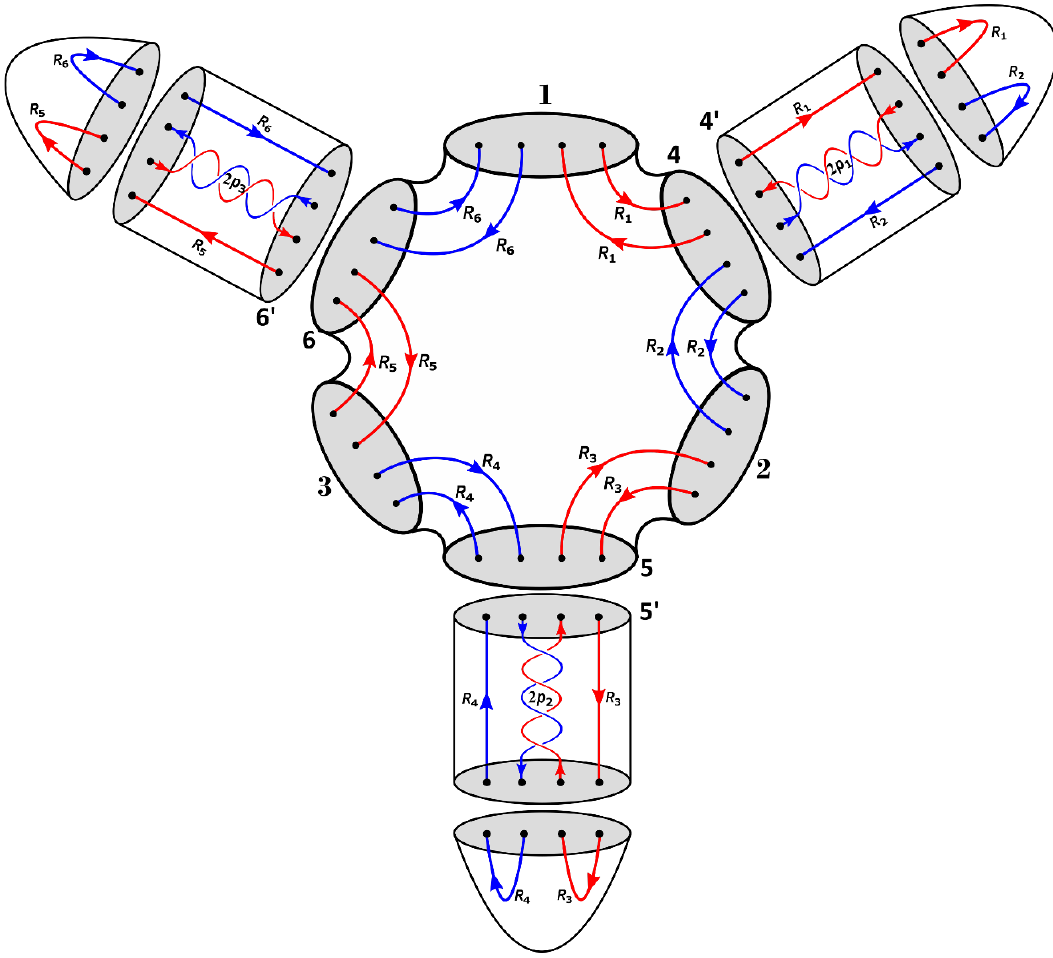
Ψ for n = 3. The S 2 boundaries labeled 4 (cid:30) |